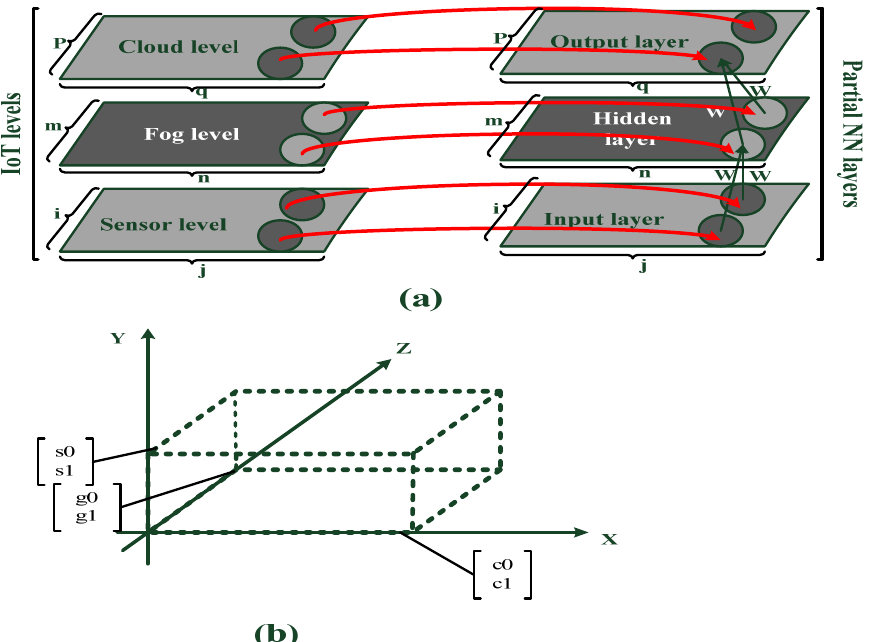
Figure 4. Quasi-mapping IoT’s nodes onto the partial NN’s nodes: ( a ) Quasi-mapping IoT’s nodes; ( b ) 3D structure of IoT.